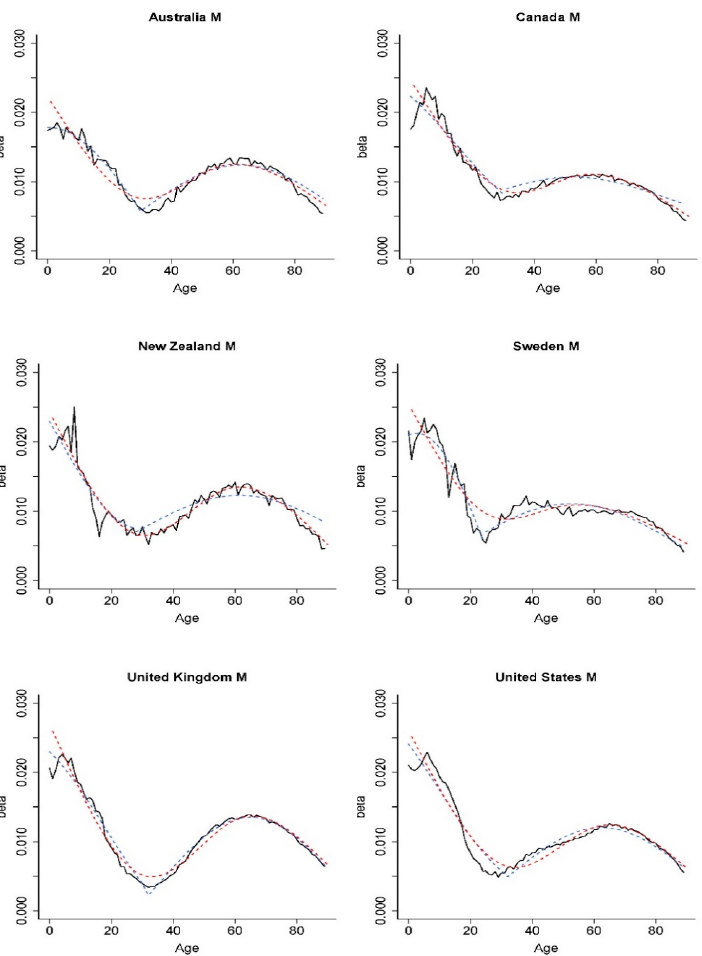
Figure 5. Estimated (solid lines) and fitted (dashed lines) age sensitivity factor under the Lee-Carter model estimated from the latest 24-year subperiod. The blue (red) lines refer to fitted values using the Fourier (cubic-spline)